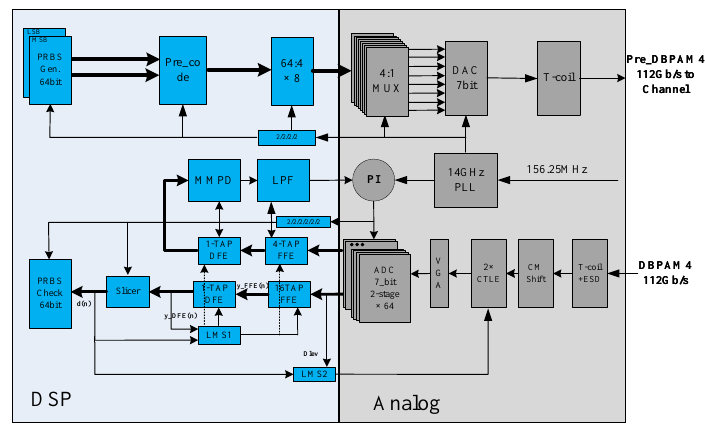
Figure 1. Adaptive equalizer overall